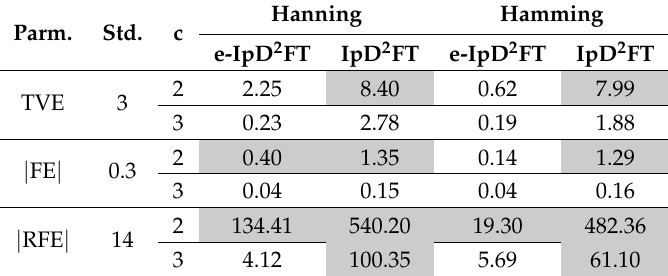
Table 5. Maximum TVEs (%), | FE | s (Hz) and | RFE | s (Hz/s) returned by the e-IpD 2 FT and IpD 2 FT in the “frequency deviation + second harmonic + modulation” test. The meaning of the gray cells is the same as in Table 4.